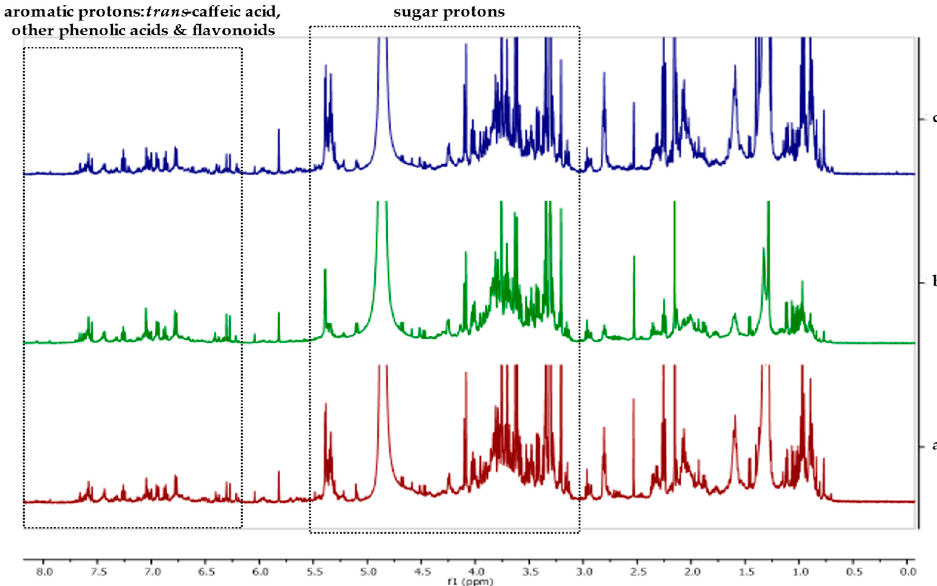
Figure 1. Representative 1 H-NMR spectra of the hydromethanolic extracts of Sambucus nigra leaves from genotype GR-1-BBGK-19,596 under ( a ) no fertilization (control), ( b ) conventional, and ( c ) organic fertilization treatments (CD 3 OD, 500 MHz). Chemical shifts are reported in ppm on the x -axis (0.0 – 8.0). Table 5. Effect of fertilization regimes (conventional, organic, and control with no fertilization) on